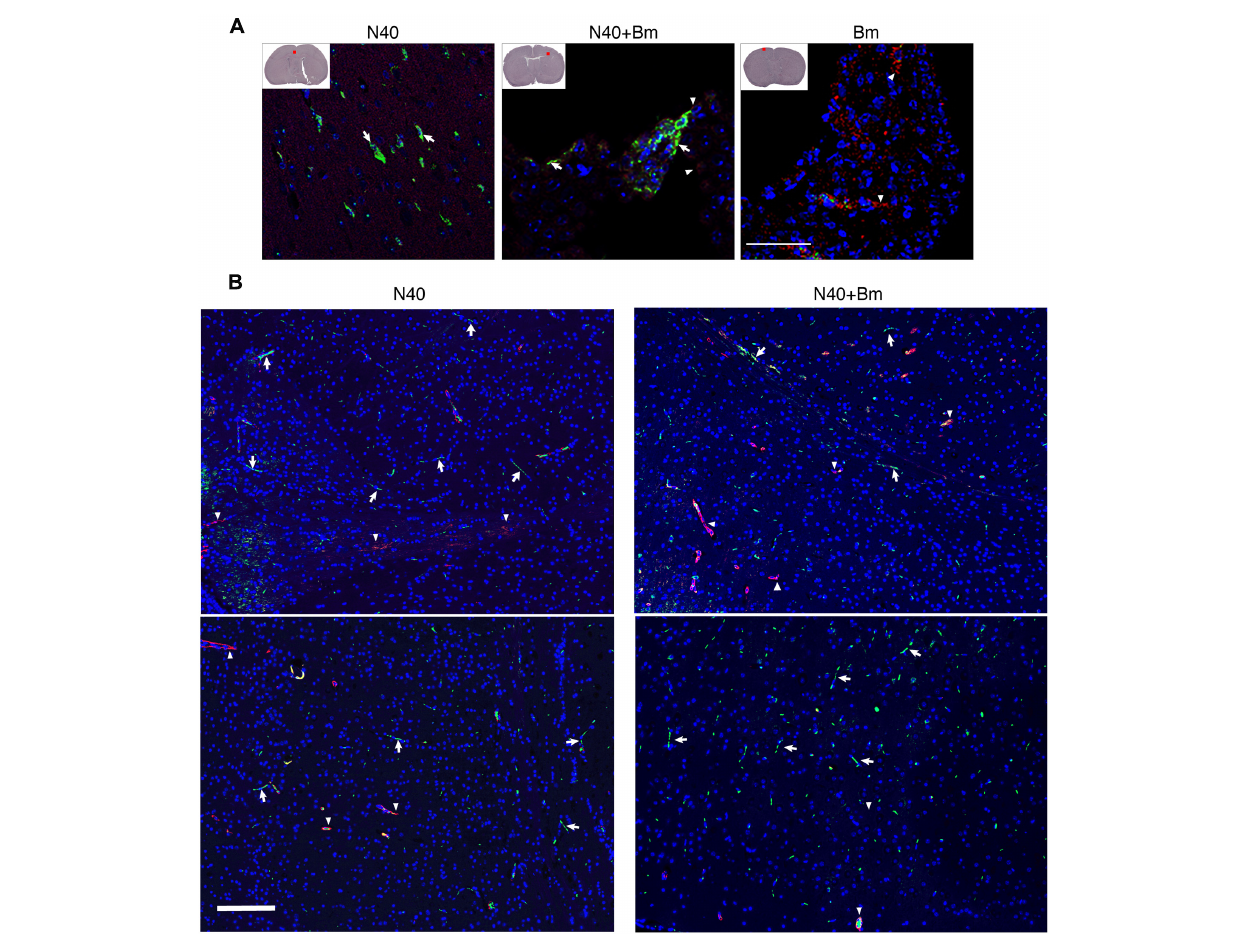
FIGURE 9 | Borrelia burgdorferi N40 strain infection with or without B. microti co-infection resulted in colonization of the forebrain at day 21 p.i., as shown in multiple sections by immunostaining. (A) Deeply anesthetized mice were perfused with PBS and fixative before euthanasia. Brain sections were labeled with anti- B. burgdorferi antibodies conjugated to FITC (white arrows) and endothelial cells using anti-CD31 antibodies tagged with PE (red), marked by arrowheads. The nuclei of the host cells are stained blue by DAPI. Aggregates of green spirochetes (arrows) were detected in brain sections from N40 infected and co-infected mice when examined by Nikon Eclipse Ti A1 scanning confocal microscope. Control B. microti infected mice brain did not show any spirochetes. (B) Additional sections of brains of mice infection with N40 alone or co-infected with B. microti also showed presence of the spirochetes when the sections were examined using Nikon